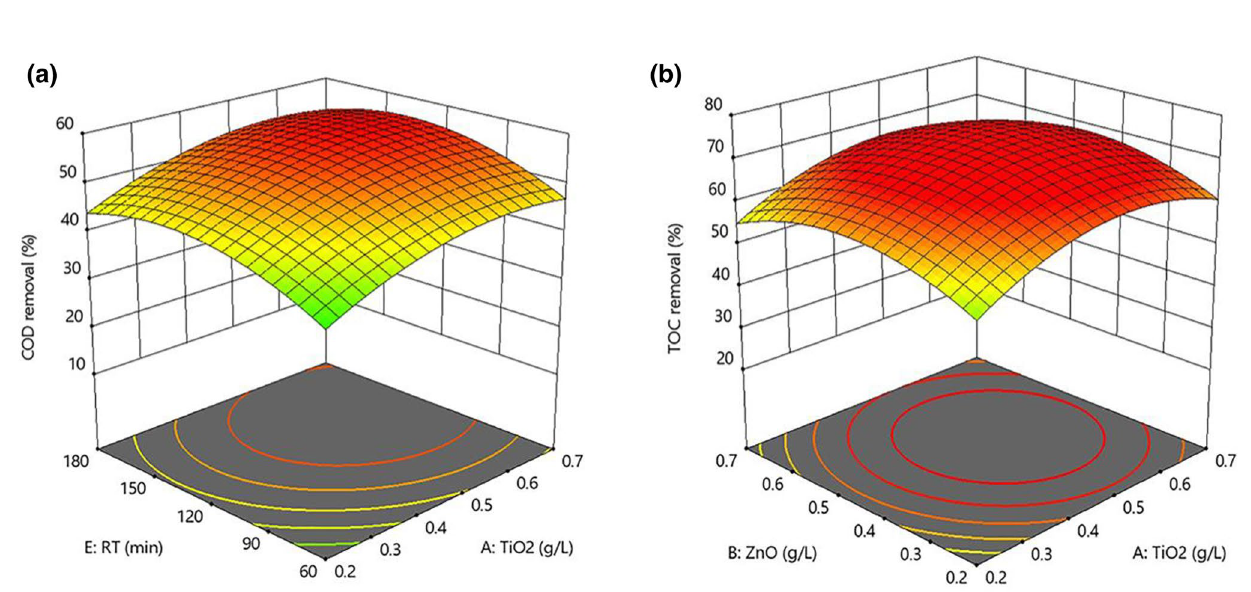
Fig. 4 a 3D plot for COD removal (%) versus reaction time (RT) and versus ZnO (g/L) and TiO 2 (g/L) at optimum settings of H 2 O 2 TiO ZnO dosage = 0.502 g/L dose = 0.745 mL, pH = 7 and reaction time (RT) = 162.2 2 dosage at optimum settings of pH = 7.0, and H 2 O 2 dosage = 0.745 mL/L. b 3D-plot for TOC removal (%)